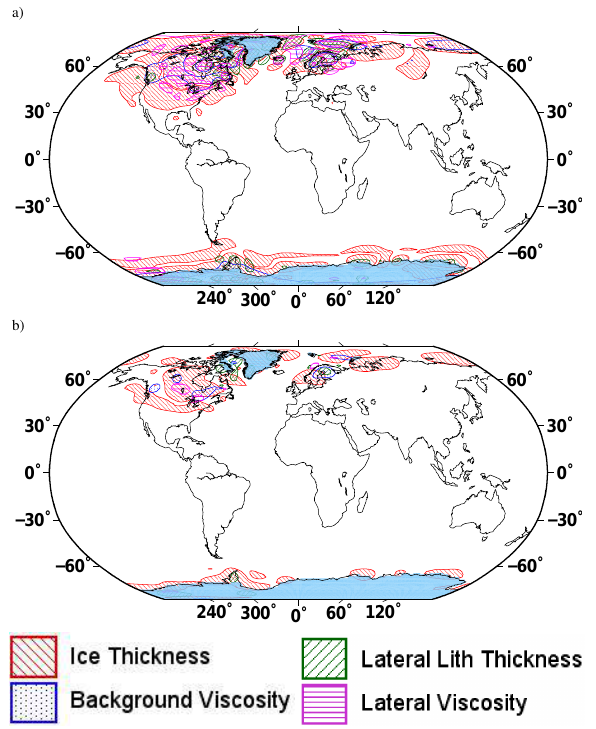
Fig.7. Same as Fig.5, butfor (a) 4,and (b) 2 ka. Figure 7. Same as Fig. 5, but for (a) 4, and (b) 2ka.